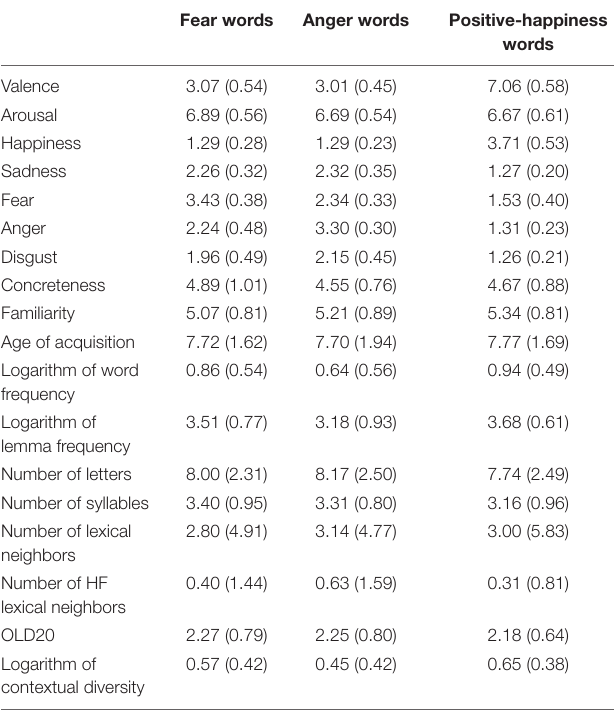
TABLE 1 | Lexical, semantic and affective features of the experimental stimuli and the filler stimuli (standard deviations in